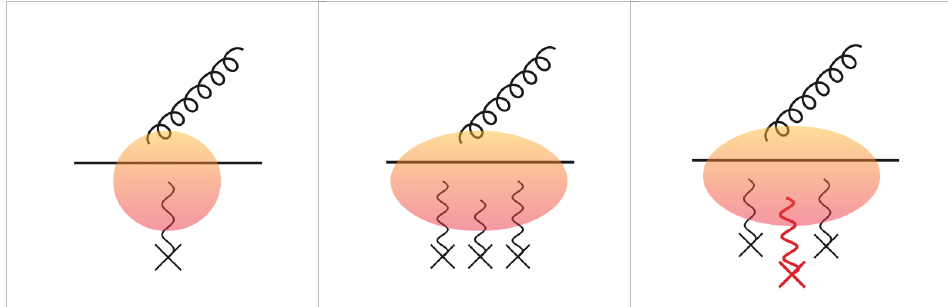
Figure 1 . Three regimes of the radiative spectrum in dense media, L (cid:29) λ : the Bethe-Heitler regime ω < ω (leftmost), the BDMPS-Z regime ω < ω < ω c (middle), and the hard GLV regime BH BH ω c < ω (rightmost figure). The size of the blob represents the typical formation time of the emission, which is t f < λ in the leftmost panel and t f > λ in the center and rightmost panels. Black, wavy lines represent soft interactions with the medium, where the momentum transfer is of the order of the medium scale | q | . µ , while the red, wavy line represents a hard scattering event, with | q | (cid:29) µ